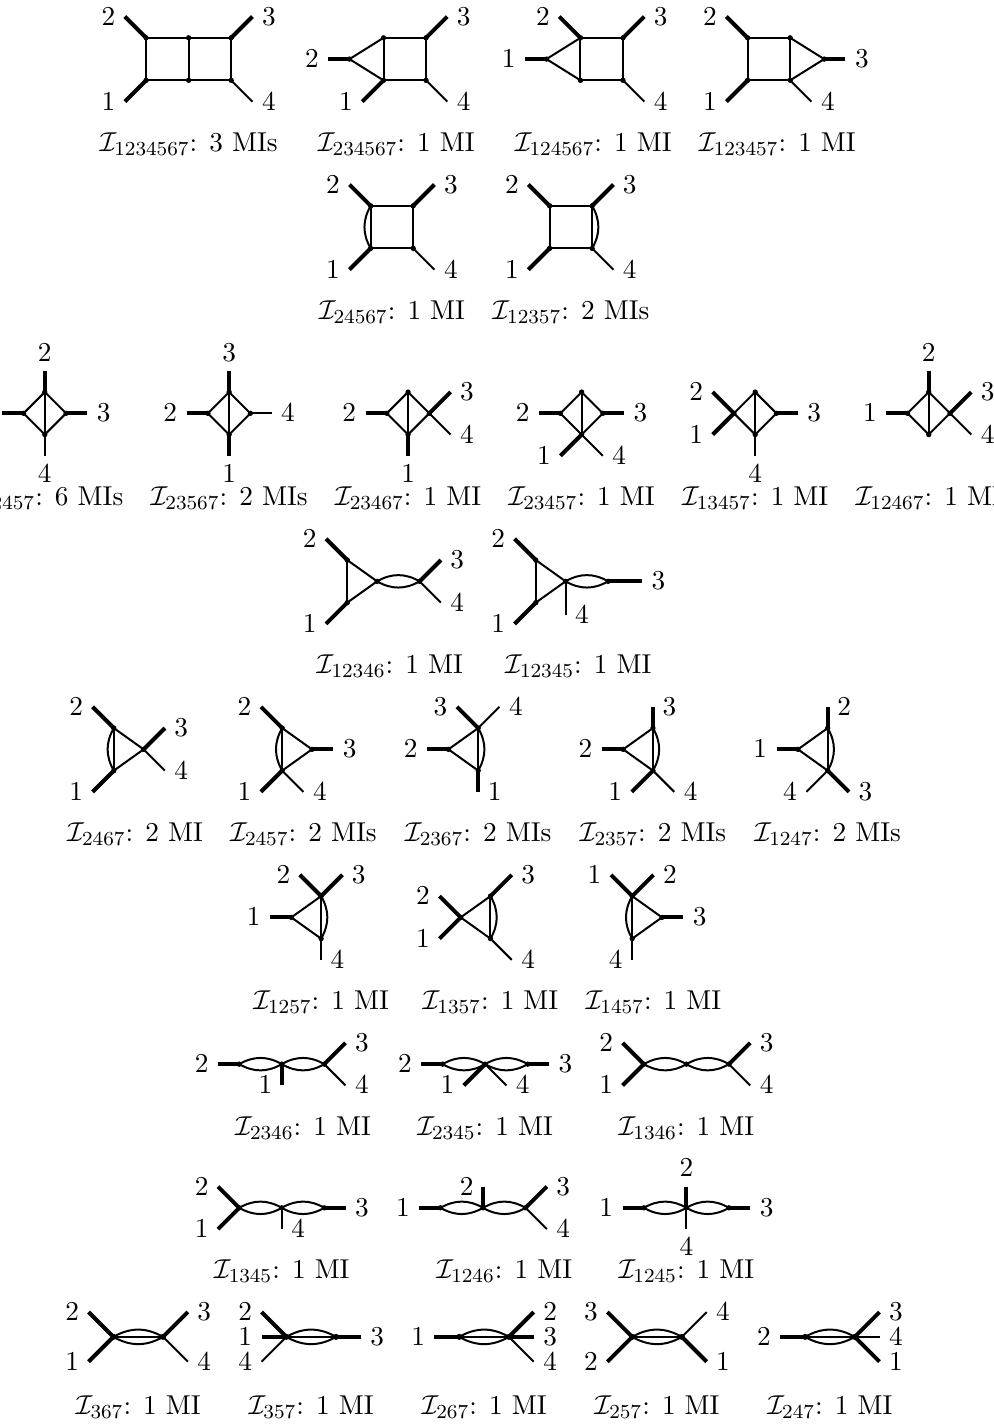
Figure 3 . The different topologies of the MIs. The thick external lines represent massive external momenta. The sectors I are labeled by the lines that are present in the diagram and we also show the number of master integrals in each